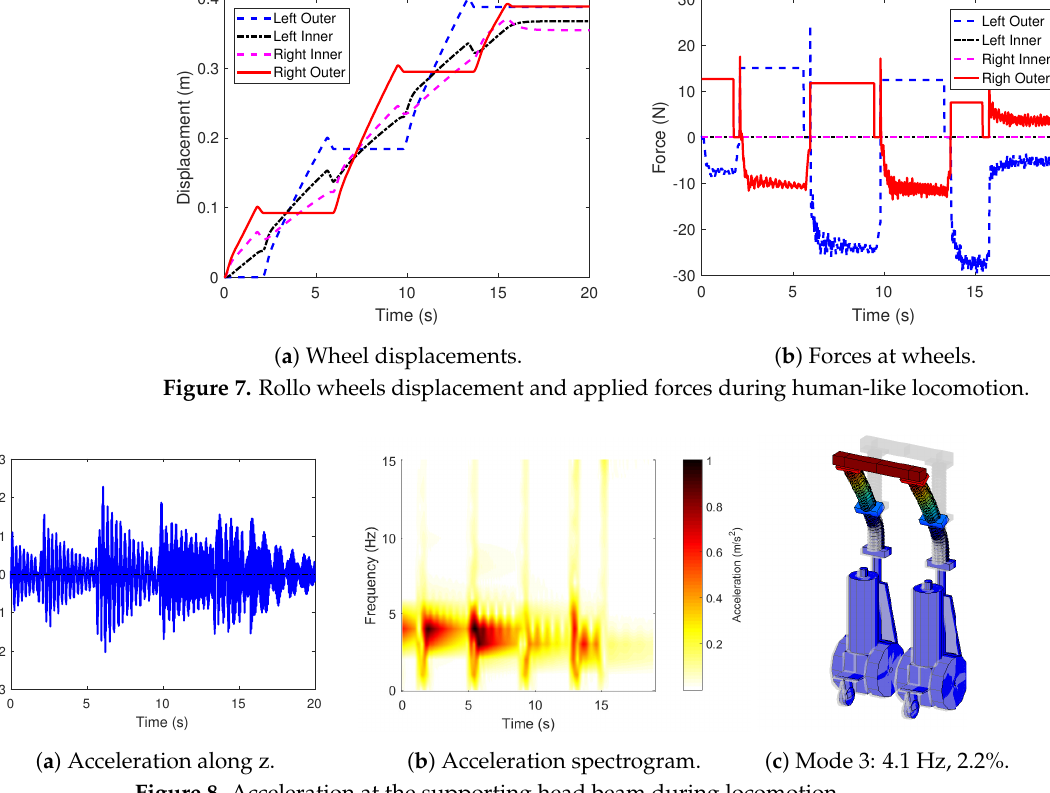
Figure 8. Acceleration at the supporting head beam during